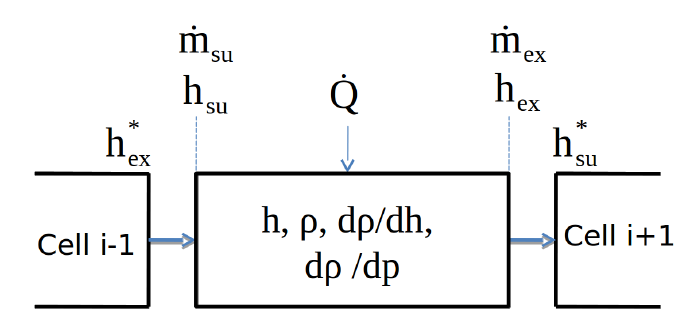
Figure 1. Discretized flow model with cells and node